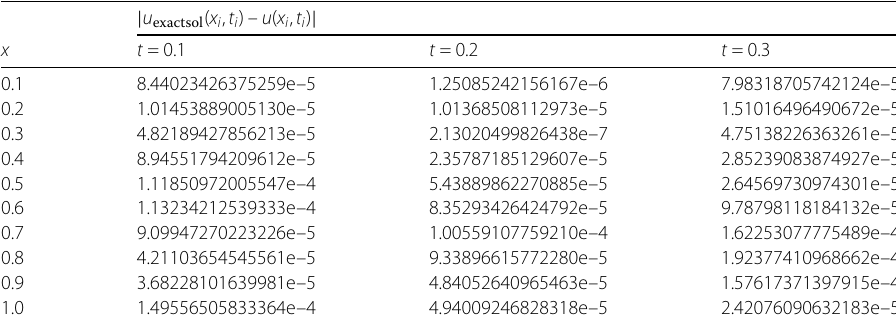
Table 1 Comparison of maximum absolute errors acquired using the GWGM for β = 1/2, α = 1 of Example 1 with given initial and boundary conditions